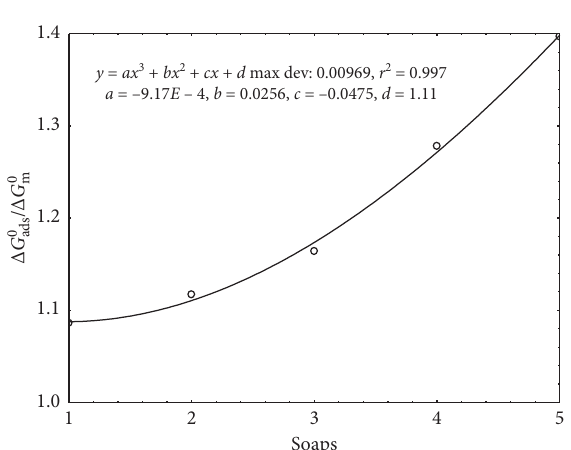
Figure 16: Variation of ( Δ G o